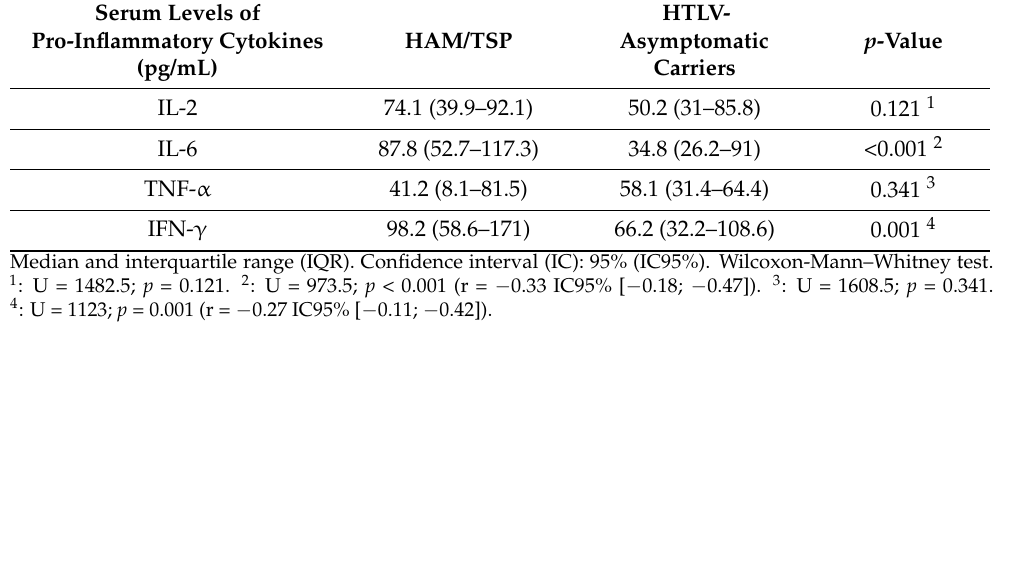
Figure 1. Proportion (%) of subjects with normal/abnormal vitamin D levels according to HTLV status and ambulation capacity. Table 4. Comparison between serum levels of proinflammatory cytokines (IL-2, IL-6, TNF- α and IFN- γ ) between the HAM/TSP patients and HTLV-asymptomatic carriers. Serum Levels